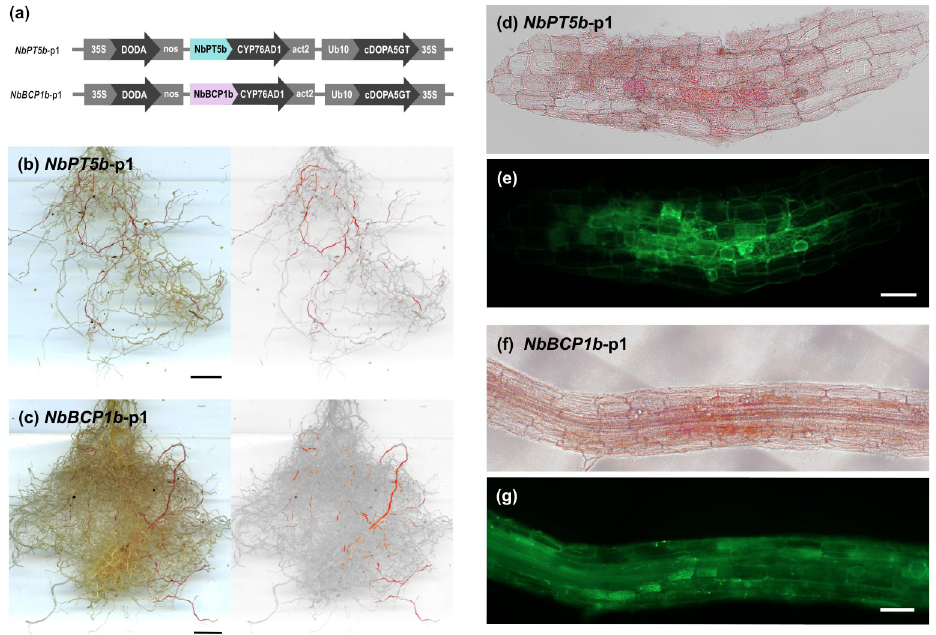
Fig 5. Betalains can be produced in Nicotiana benthamiana roots as a response to AM fungi colonisation. (a) Schematic of the multigene vectors constructed for inducible betalain expression in N . benthamiana roots where only the first gene of the betalain biosynthesis pathway is controlled by AM symbiosis–specific promoters. Expression of Rhizophagus irregularis . Right: Root images are filtered for red colour. (d–g) Confocal microscopy of red NbPT5b-p1 (d and e) and NbBCP1b-p1 (f and g) transgenic root sections which were cut and stained with WGA-FITC to visualise fungal structures. (d and f) colour-filtered for red; (e and g) FITC green fluorescence. Scale bar (b and c), 1 cm; scale bar (d–g), 100 μ m. AM, arbuscular mycorrhiza; WGA, wheat germ agglutinin.